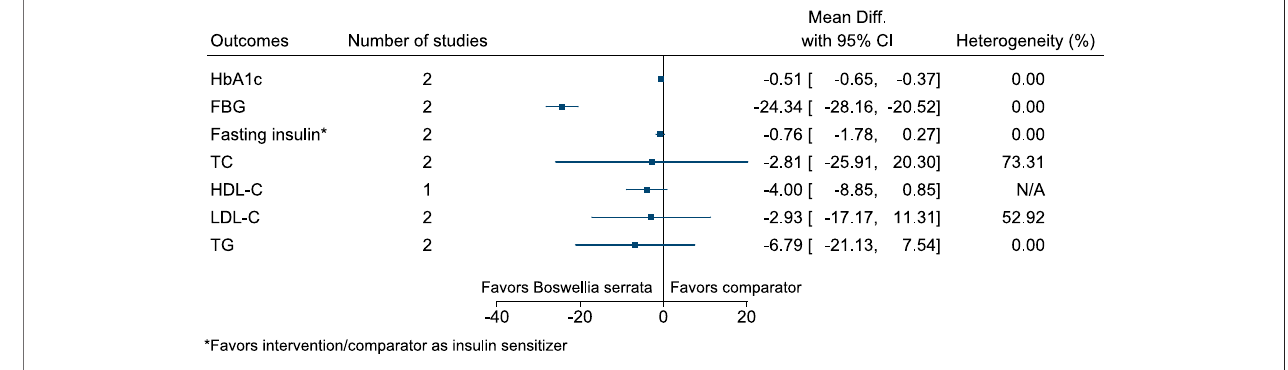
FIGURE 7 | Boswellia serrata — Summary forest plot.